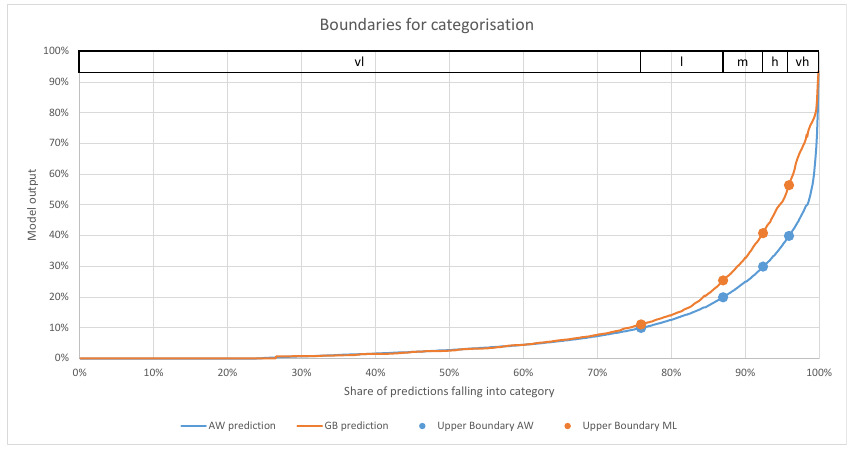
Figure 1. Boundaries for test predictions using the classification boundaries shown in Equations (4) and (5). The boundaries were chosen such that the group sizes are identical using GB and AW.